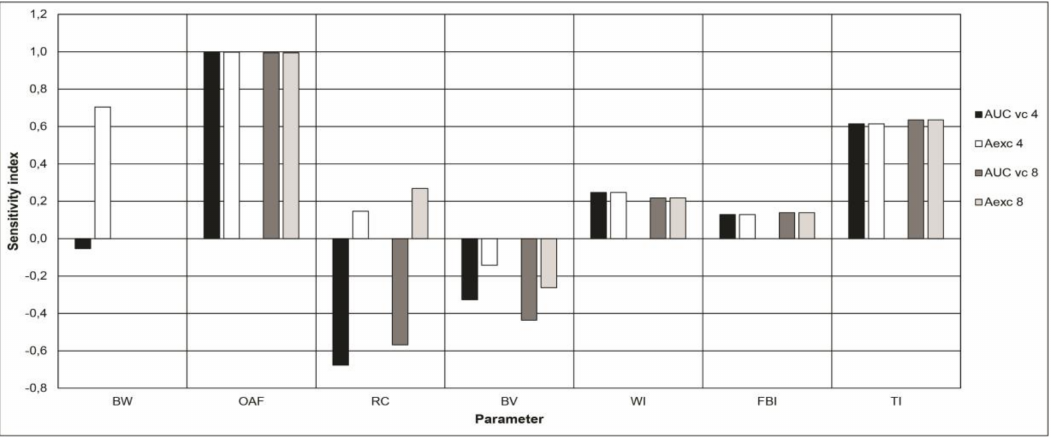
Figure 6. Sensitivity indices of the model parameters above the arbitrarily determined threshold of 0.05. Symbols: BW: Body weight. OAF: Oral absorption fraction. RC: Renal clearance. BV: Bone volume. WI: water intake. FBI: Food and beverages intake. TI: Toothpaste intake. AUC vc 4: Area under the curve of venous concentrations of fluorides over 24 h for a 4-year-old child. AUC vc 8: Area under the curve of venous concentrations of fluorides over 24 h for an 8-year-old child. Aexc 4: Amount of urinary fluorides excreted over 24 h for a 4-year-old child. Aexc 8: Amount of urinary fluorides excreted